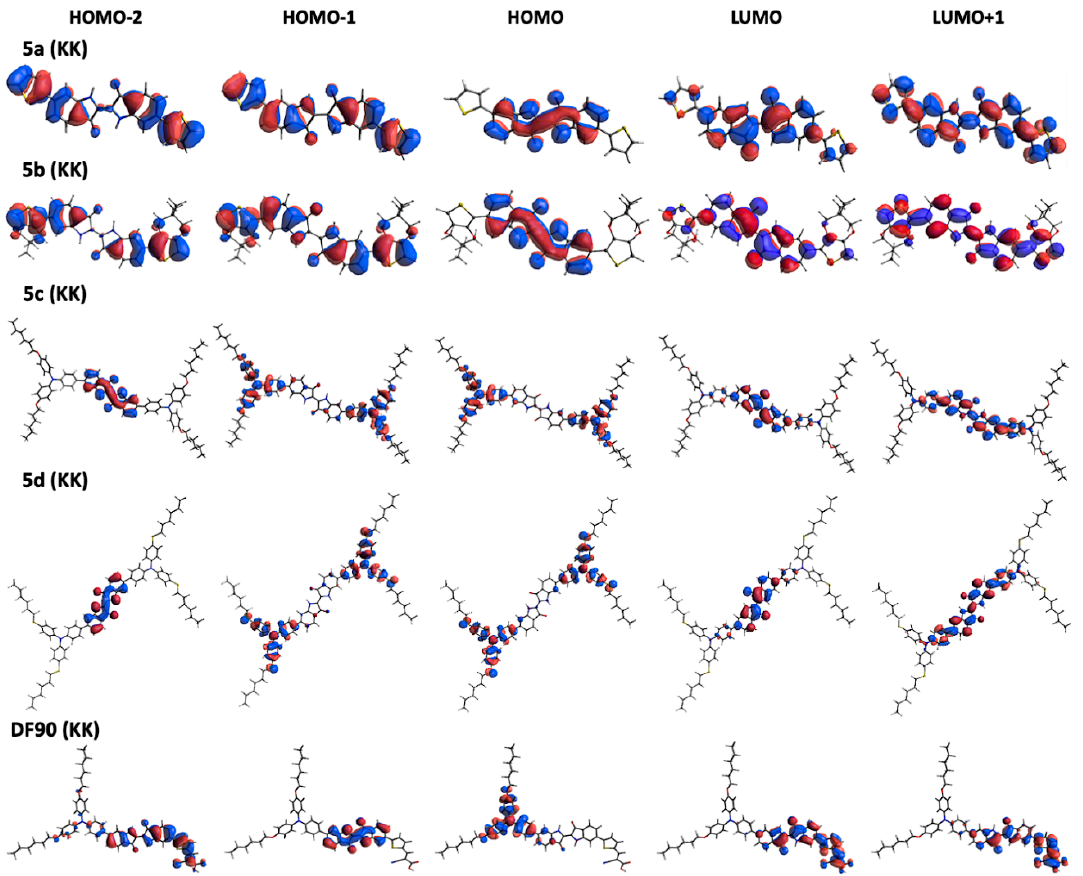
Figure 3. B3LYP / 6-31G** ground-state electron density distributions in DCM of KK tautomer of Figure 3. B3LYP/6-31G** ground-state electron density distributions in DCM of KK tautomer of compounds 5a , 5b , 5c , 5d and DF90 compounds 5a , 5b , 5c , 5d and DF90 .